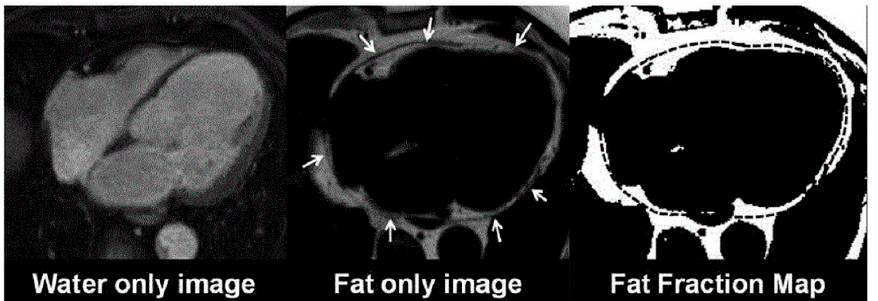
Figure 3. CMR Dixon images. A: Fat only image. B: Fat only Image with the epicardial outlines (arrows). C: Segmented fat voxels with the transferred region of interest. CM: cardiac magnetic resonance. Kropidlowski C, et al. Int J Cardiol Heart Vasc. 2020;27:100477, under Creative Commons license 4.0.